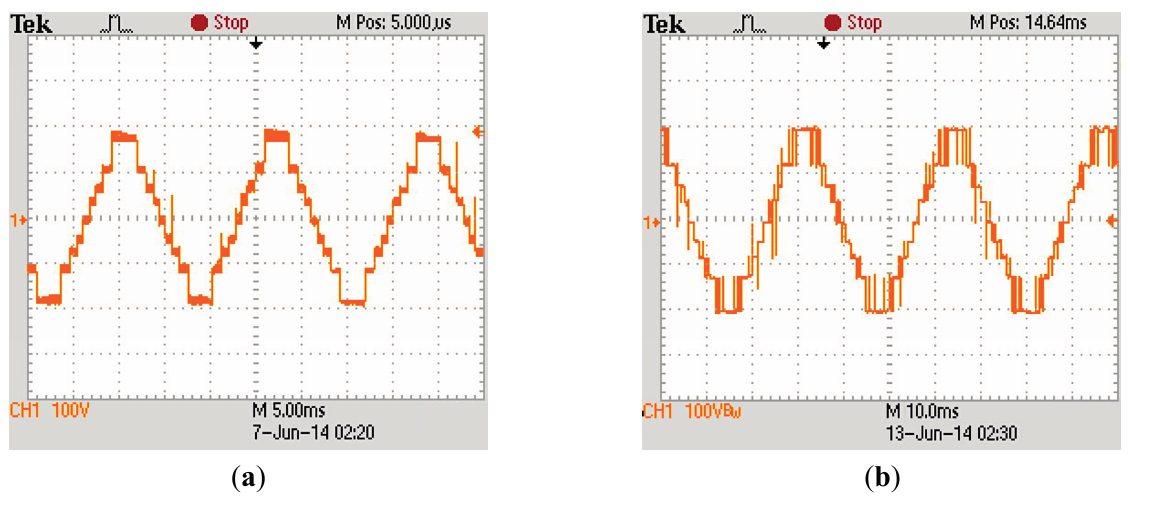
Figure 14. V out ( a ) multilevel V out ( b ) SPWM multilevel V out